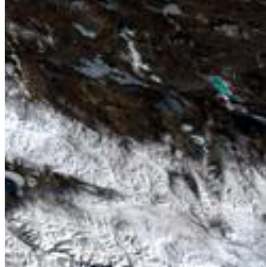
Figure5. The results of 10-day composite snow